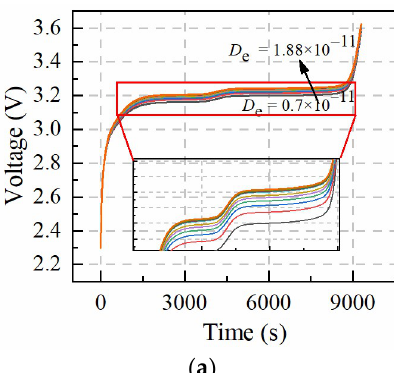
Figure 4. Sensitivity curves of battery terminal voltage to D e under different charging rates. ( a ) Sen- sitivity curves under 0.5 C charging rate; ( b ) Sensitivity curves under 1 C charging rate. ( a )